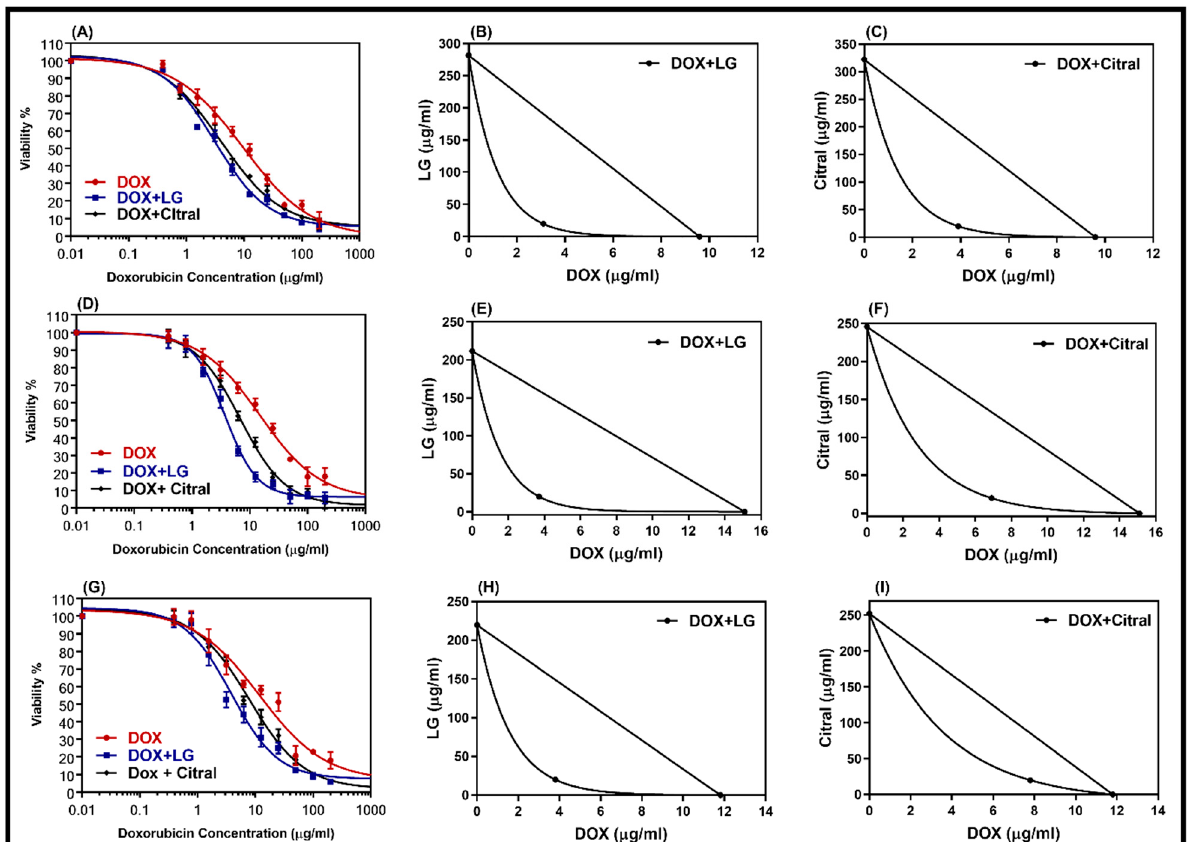
Figure 3. Dose–response curves of doxorubicin alone and in combination with LG or citral in resistance cell lines HepG-2/ADR ( A ), MCF-7/ADR ( D ), and SKOV3/ADR ( G ). The isobologram of DOX with LG ( B , E , H ) and of DOX with citral ( C , F , I ) showed a synergism interaction in the tested cells, respectively. Individual cell lines were incubated for 24 h with several concentrations (0.01–200 µg/mL) of DOX with a non-toxic concentration of 20 µg/mL of either LG essential oil or the major constituent, citral. The cell proliferation was evaluated using an MTT assay. Table 3. Synergistic interaction of a combination of DOX with LG and citral (20 µg/mL) in HepG-2/ADR-, MCF-7/ADR-, and SOVK-3/ADR-resistant cell lines.